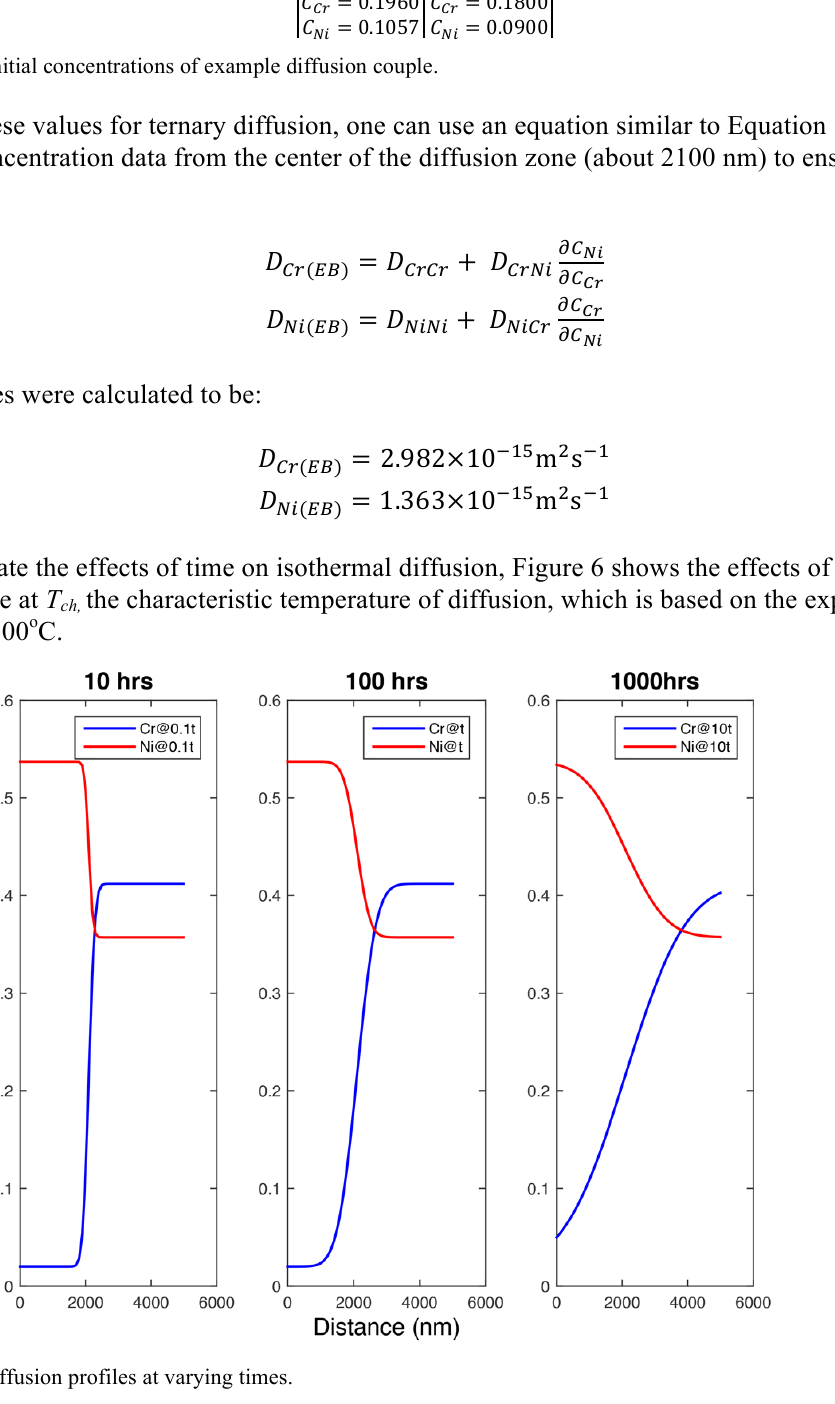
Figure 6. Initial concentrations of example diffusion